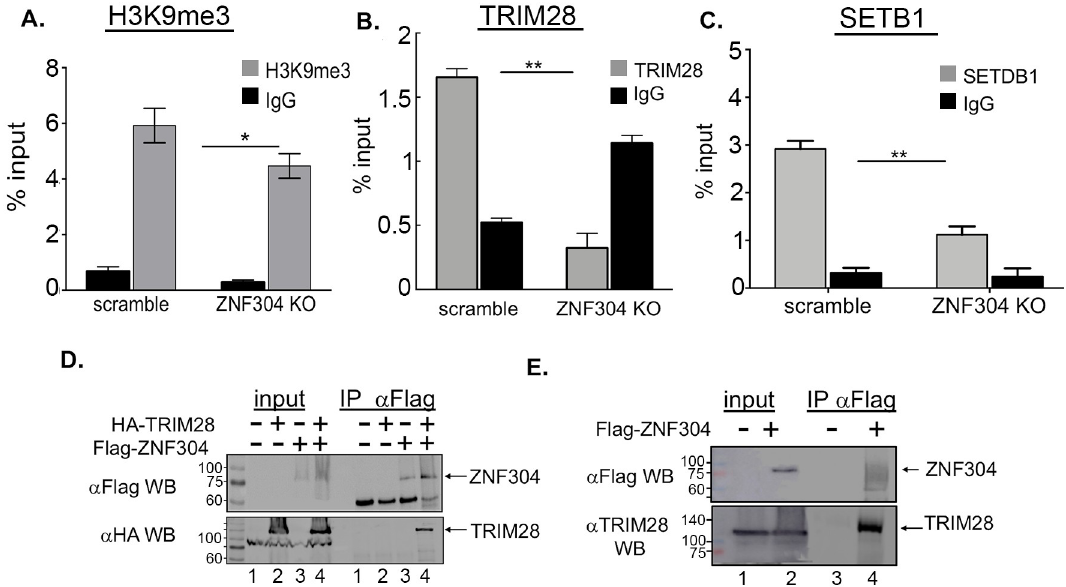
Fig 5. ZNF304 mediates H3K9me3 histone marks on the HIV promoter through TRIM28 and SETB1 to silence HIV gene transcription A-C. ChIP material was isolated from control or ZNF304-depleted T cells—Immuno-precipitation was conducted with H3K9me3 ( A ), TRIM28 ( B ) and SETB1 ( C ). Non-specific rabbit IgG (black bars) was used as control. qPCR on IP samples was conducted with primers located on the HIV promoter, and signals are presented as a percentage of input. Error bars represent means ± SD of three independent qPCR reactions. Asterisks indicate different levels of statistical significance as calculated by a two- tailed Student’s t test ( �� p � 0.01; � p � 0.1). D . ZNF304 associates with TRIM28 in cells –HEK293T cells expressing HA-TRIM28 and Flag-ZNF304 were subjected to immunoprecipitation with Flag IgG. IP samples were then subjected to SDS-PAGE and western blot with HA IgG. Input samples represent 10% of the total cell lysate. E. ZNF associates with endogenous TRIM28 in cells- HEK293T cells expressing Flag-ZNF304 were subjected to immunoprecipitation with Flag IgG. IP samples were then subjected to SDS-PAGE and western blot with TRIM28 IgG. Input samples represent 10% of the total cell lysate.